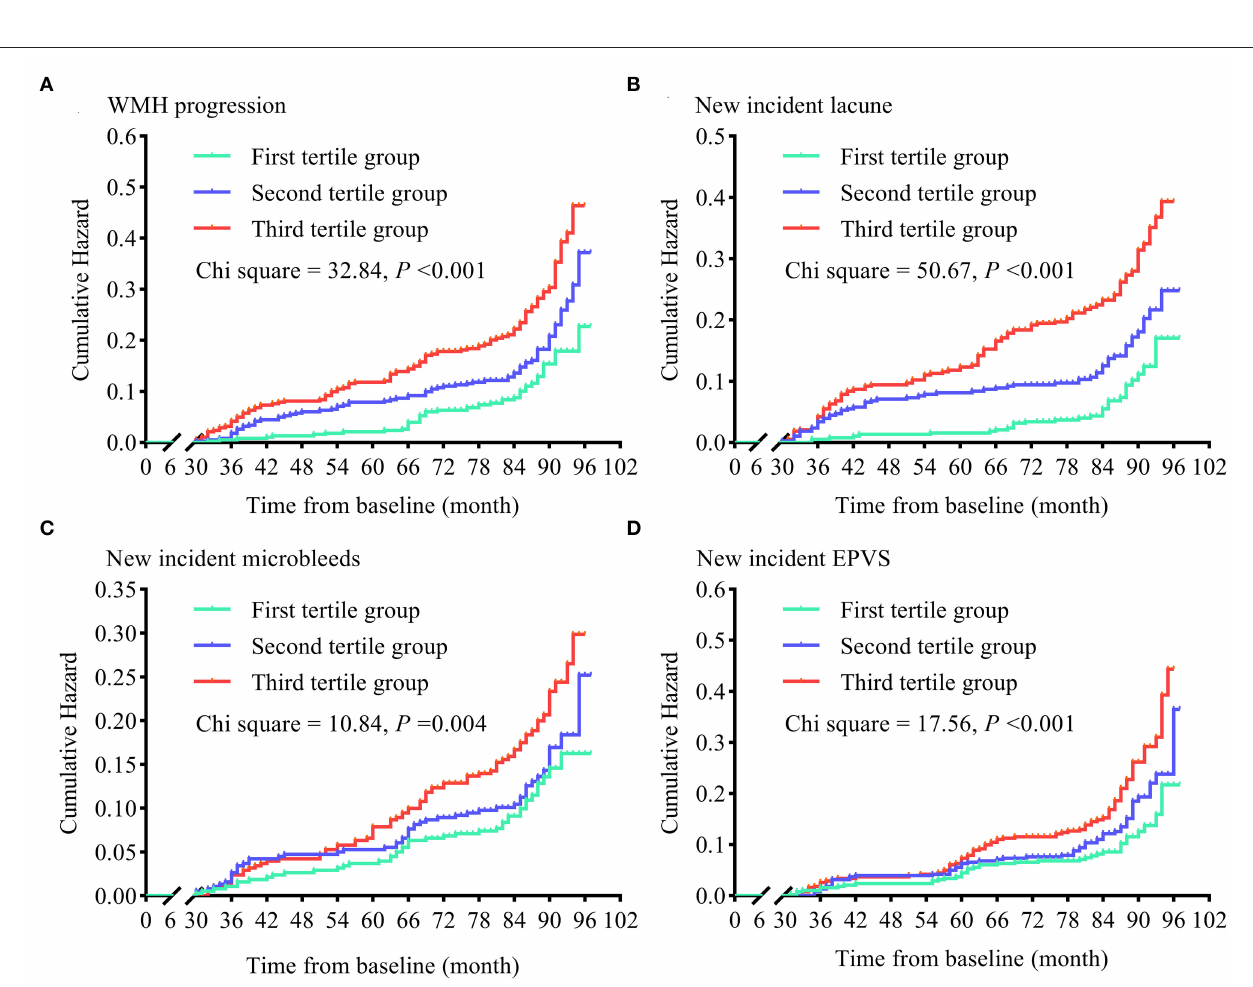
FIGURE 4 | Cumulative hazards of cerebral small vessel disease progression in tertile groups stratified by visit-to-visit sdLDL SD during the follow-up period. (A) Cumulative hazards of WMH progression. (B) Cumulative hazards of new-incident lacunes. (C) Cumulative hazards of new-incident microbleeds. (D) Cumulative hazards of new-incident EPVS. WMH, white matter hyperintensities; EPVS, enlarged perivascular space.